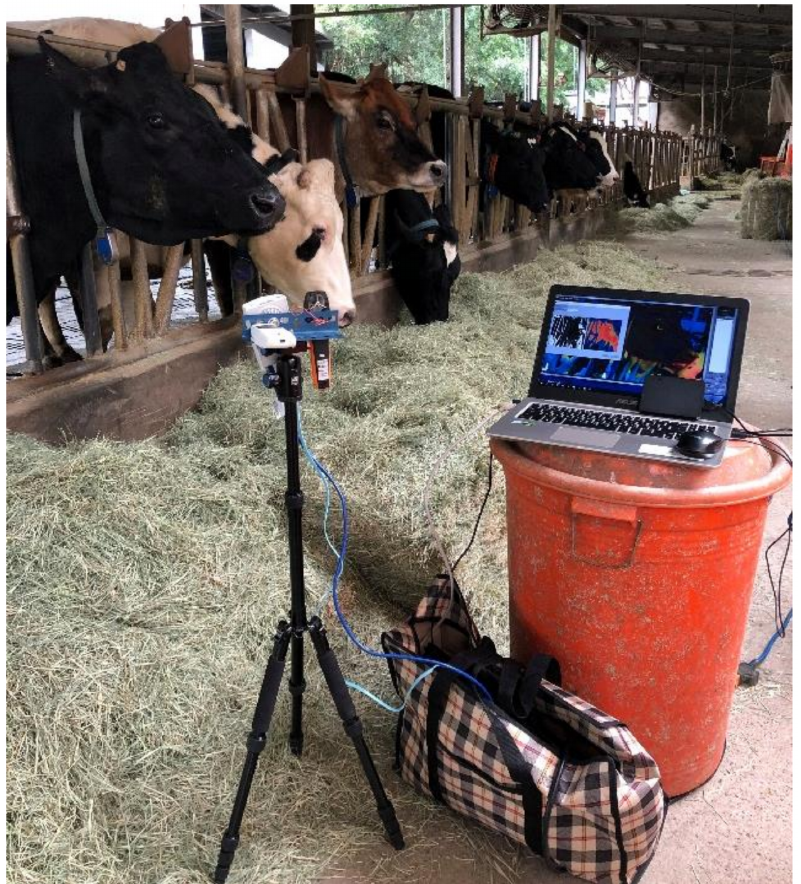
Figure 10. Photography of the experiment for noninvasive cattle body temperature monitoring.